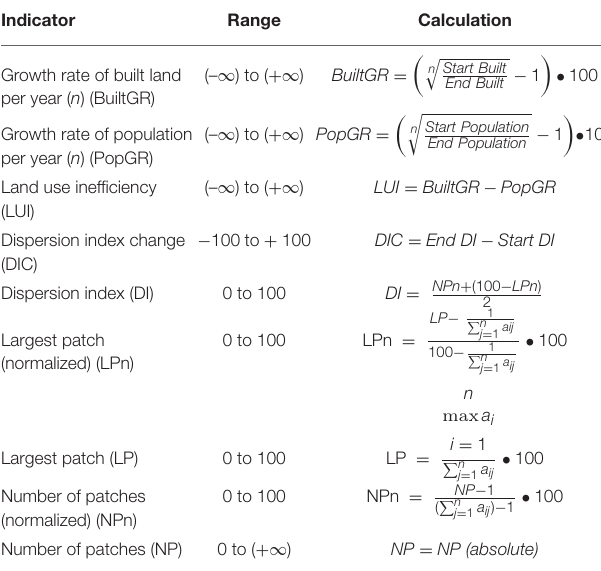
TABLE 2 | Overview of indicators and their calculation (gray = main indicators). Indicator Range